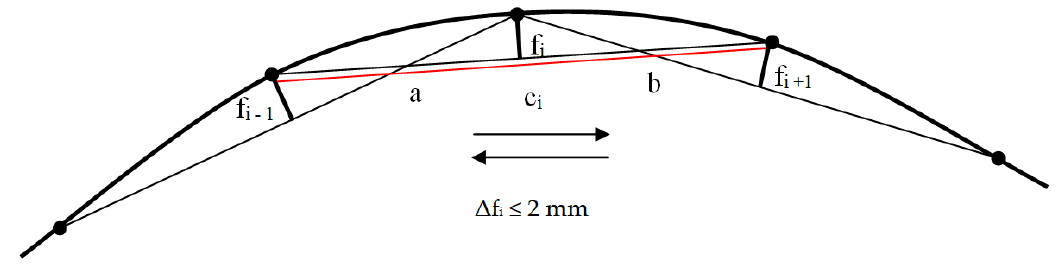
Figure 3. Horizontal versine measurement with the MMS (own Figure), where f i is the horizontal versine of the curve, c i is the chord base length, a and b are the distances between points, Δ f i is the difference between two measurements and f i-1 the value of the previous versine to the versine f i , f i+1 value of the next versine to the versine f i